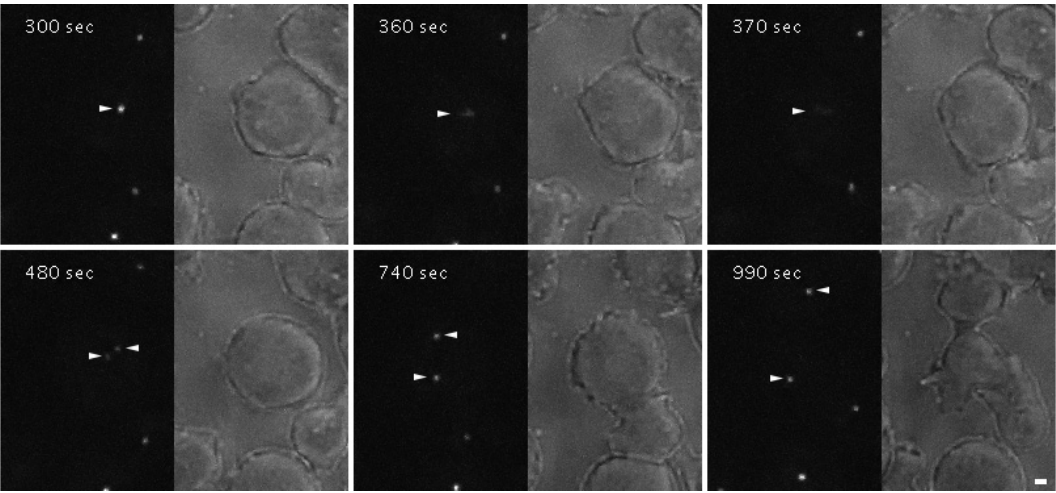
Figure 3. GFP-CDK5RAP2 briefly disappears from the centrosome during prophase. Confocal spinning disk live cell imaging of a mitotic GFP-CDK5RAP2 cell. Selected time points from Video S1 are displayed. Mitotic centrosomes are highlighted by arrowheads. Cells were viewed under agar overlay [35]. Bar = 2 µm.